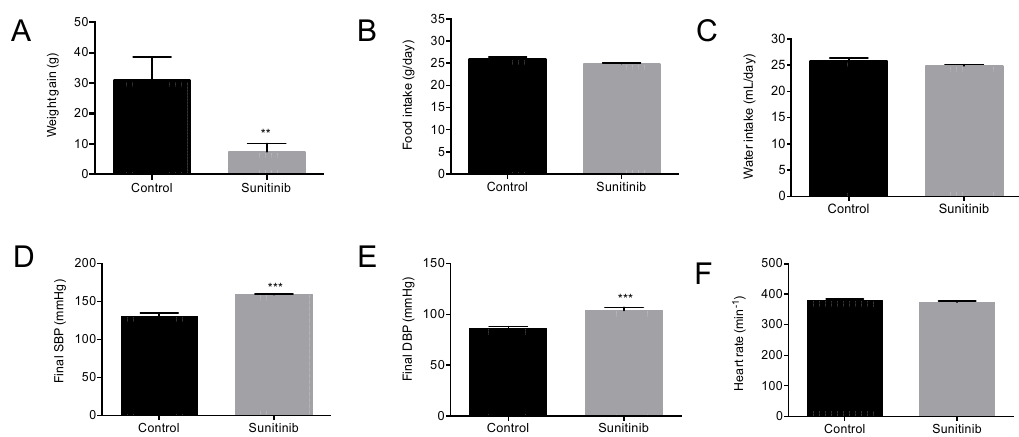
Figure 1. ( A ) Weight gain, ( B ) food intake, ( C ) water intake, ( D ) systolic blood pressure, ( E ) diastolic blood pressure, and ( F ) heart rate in control and sunitinib (Su)-treated (25 mg/kg/day) animals. Values are expressed as mean ± S.E.M. of 15 animals per group. ** p < 0.01, *** p < 0.001 vs. control group.